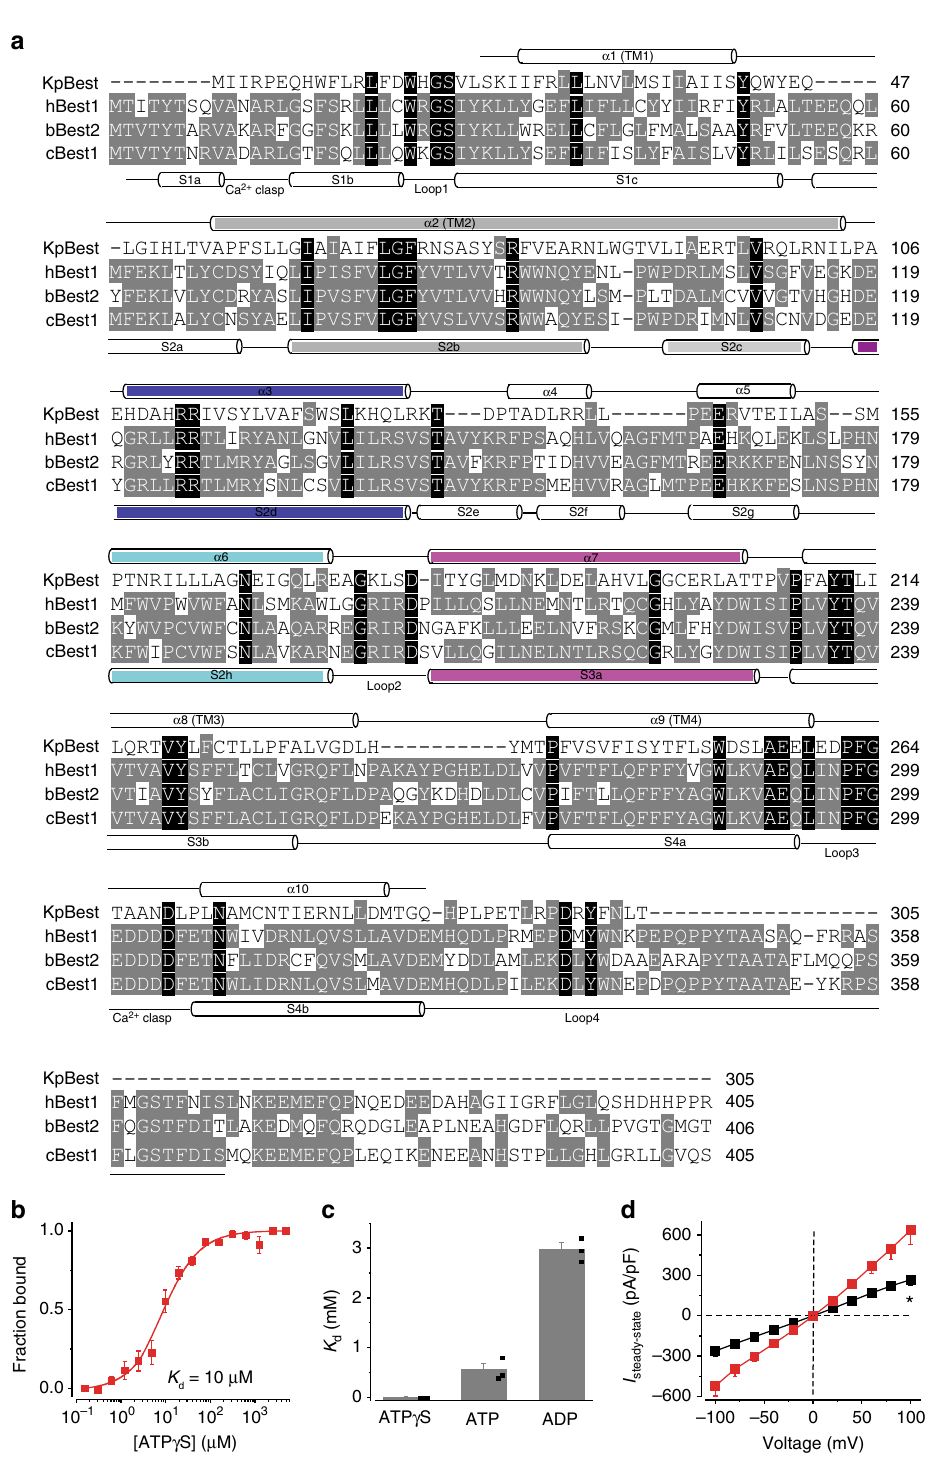
Fig. 3 ATP interacts with and activates bBest2. a Structure-based sequence alignment of KpBest, hBest1, bBest2, and cBest1. The KpBest structure is used to restrict sequence gaps to interhelical segments. Black background, identical residues in all four species; gray background, identical residues in two or three species. The secondary structures of KpBest and cBest1 are labeled above and below the sequences, respectively. The four loops (1 – 4) potentially involved in ATP binding are labeled below the cBest1 secondary structure. Critical helices potentially involved in channel activation are highlighted in the same colors as those in Fig. 7. b The MST binding curve of bBest2 to ATP γ S. Protein fraction bound vs. [ATP γ S], n = 3 for each point. c Bar chart showing the binding af fi nities of bBest2 to ATP analogs. n = 3 for each bar. d Population steady-state current – voltage relationships of bBest2 transiently expressed in HEK293 cells without (black) or with (red) ATP (10 mM), n = 9 – 13 for each point. * P < 0.05 compared to cells in the presence of ATP, using two-tailed unpaired Student t test. All error bars in this fi gure represent